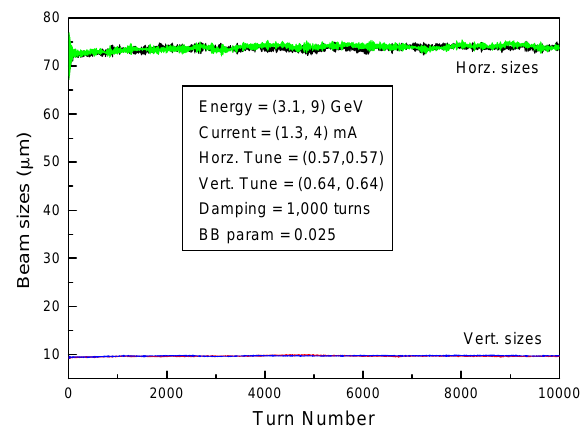
FIG. 1. (Color) Beam sizes as a function of turn number for “nominal” PEP-II parameters.